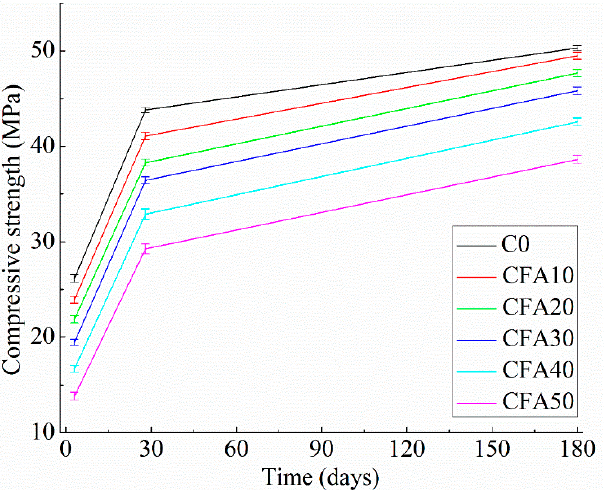
Figure 1. Compressive strength results of the face slab concretes cured at 3, 28 and 180 days.